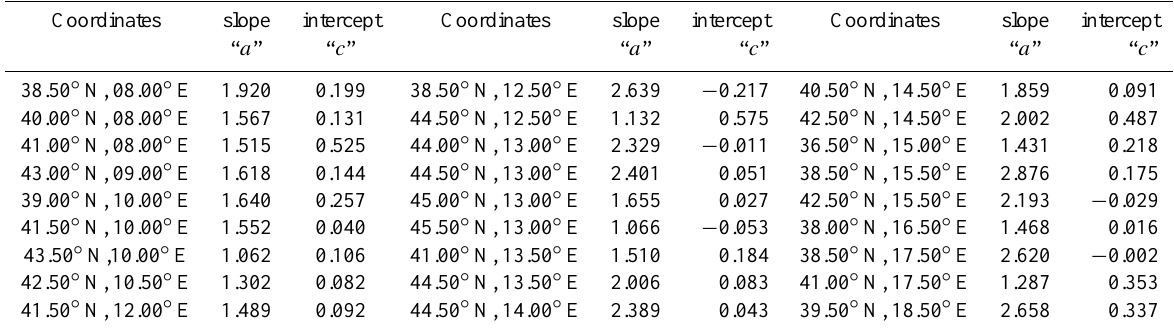
Table 1. Slope and intercept values of linear wave timeseries correction.